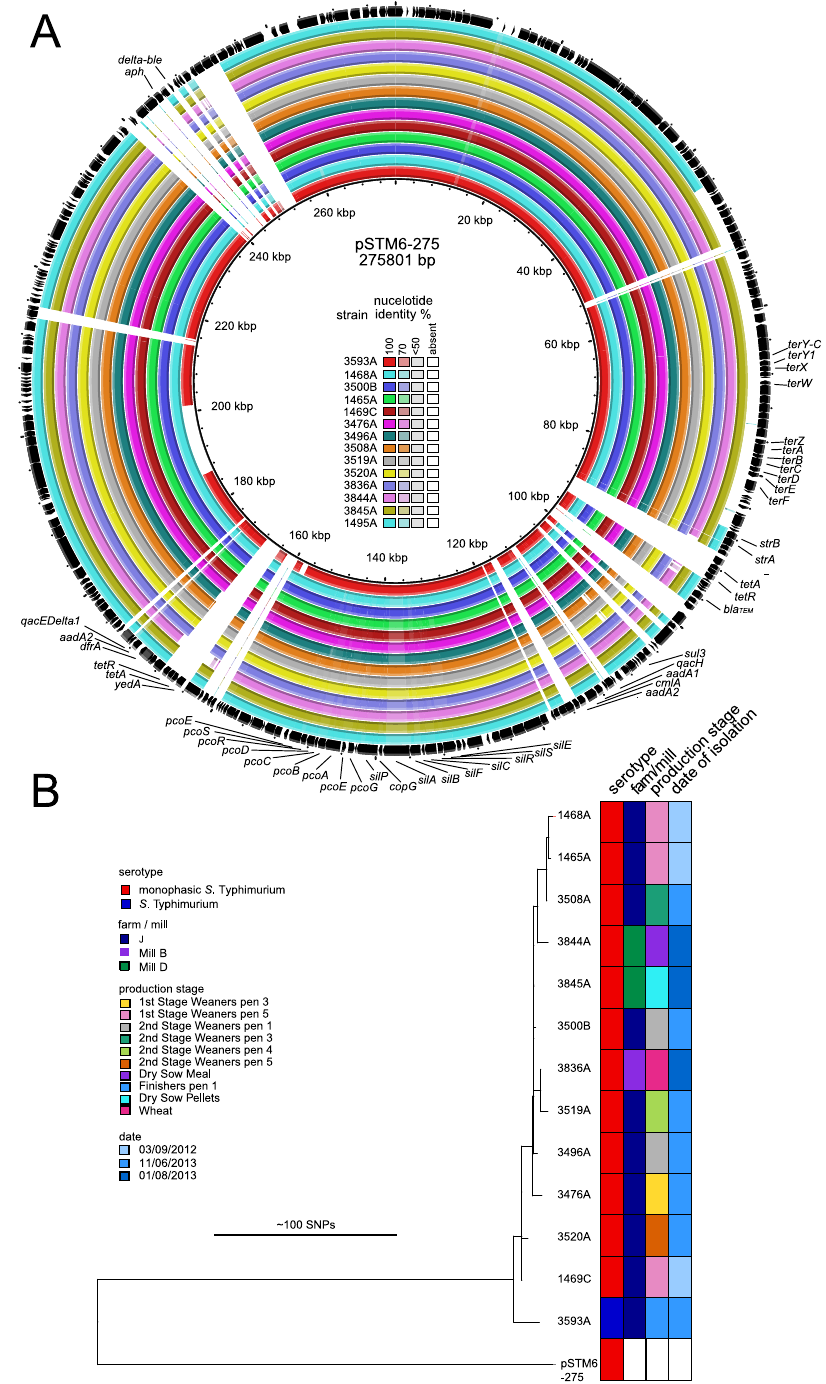
Figure 3. Sequence similarity of IncHI2 plasmids from Irish farms with the pSTM6-275 plasmid. ( A ) The extent of the homology between the Irish IncHI2 plasmids with the pSTM6-275 was visualised with BRIG. Sequence assembly contigs from each sample were blasted against the pSTM6-275, which was used as reference. Each circle represents the plasmid from each of the 14 Irish isolates. The colour gradient indicates the degree of nucleotide identity. Genes in pSTM6-275 are represented by arrows (outer circle). Genes encoding antimicrobial or heavy metals resistance genes are annotated. A detailed list of gene presence/absence is present in Supplementary Table 4. ( B ) Phylogenetic relatedness of IncHI2 plasmids. Maximum-likelihood phylogeny of the thirteen IncHI2 plasmid sequences based on 162 core-genome SNPs identified using pSTM6-275 as reference. Due to the high proportion of missing data, plasmid from isolate 1495 C was excluded from the phylogenetic